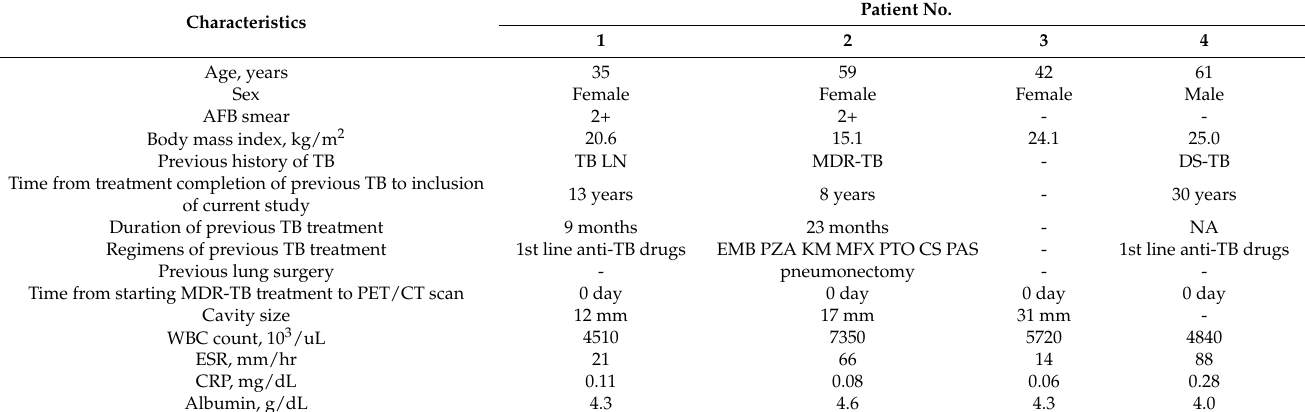
Table 1. Baseline characteristics of patients at diagnosis of multidrug-resistant tuberculosis (MDR-TB). Characteristics